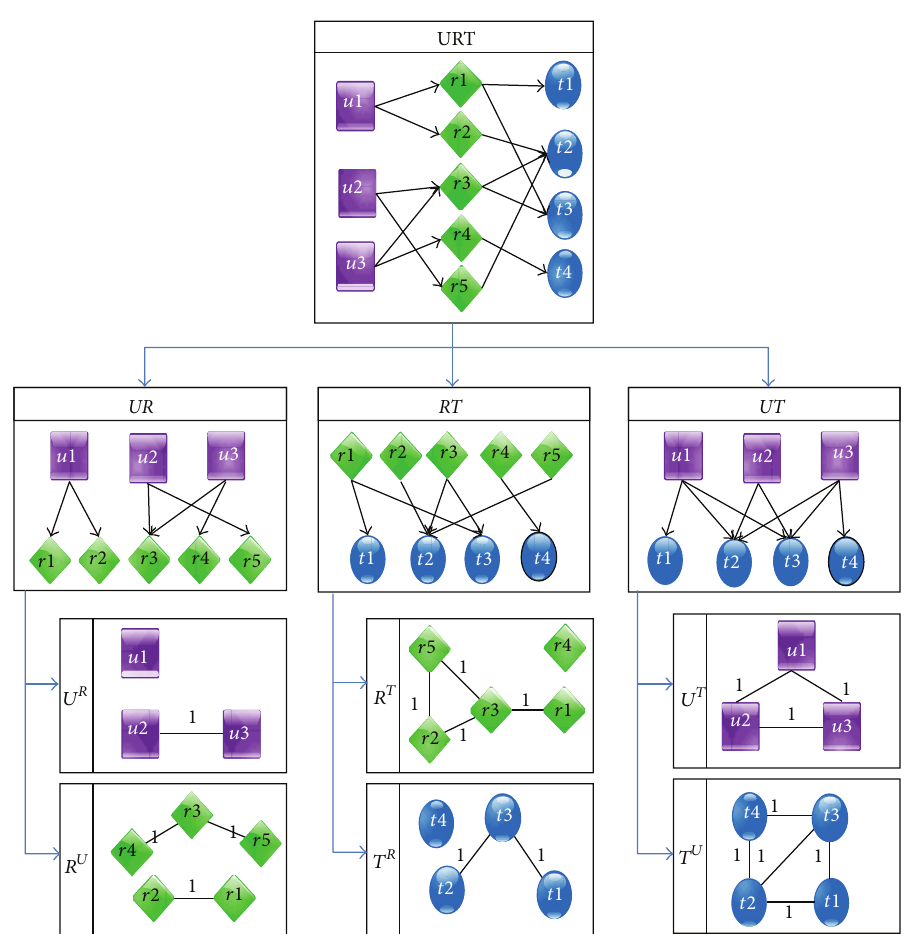
Figure 1: A process to obtain 2-mode networks and 1-mode